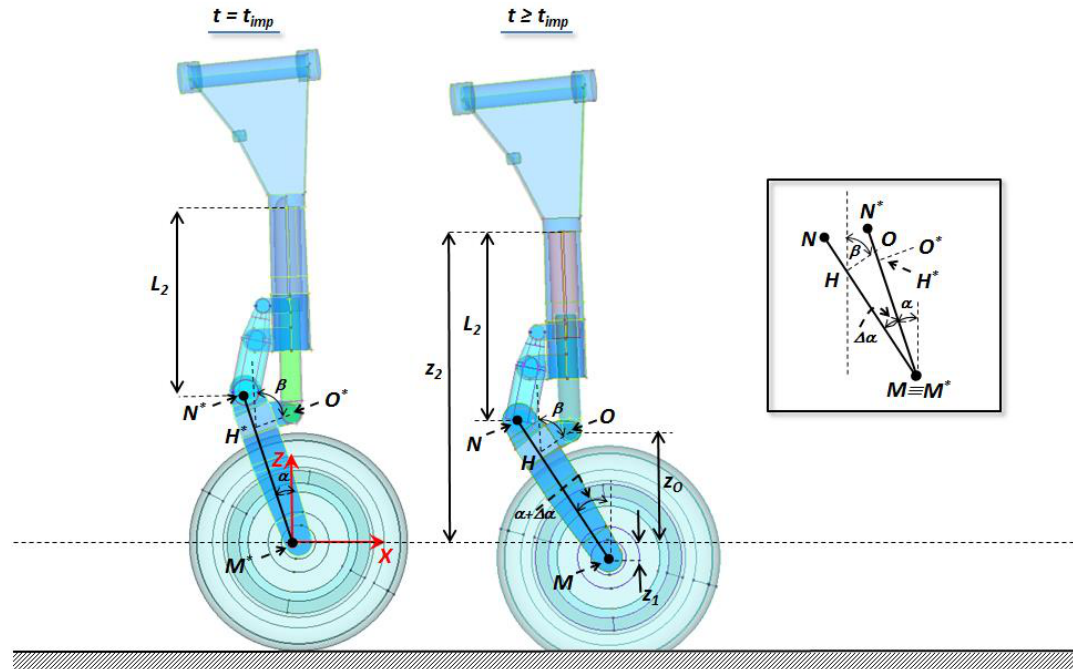
Figure A2. Reference scheme for the evaluation of the angle β.